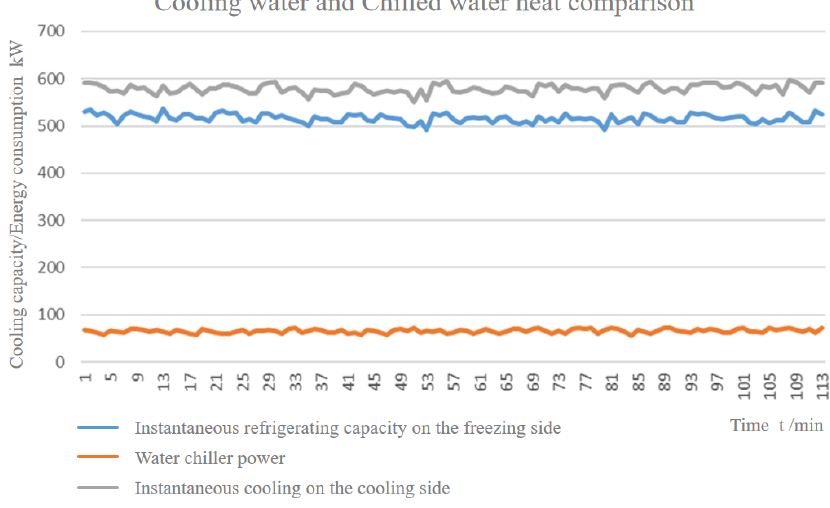
Figure 4. Cooling side versus refrigeration side cooling capacity.